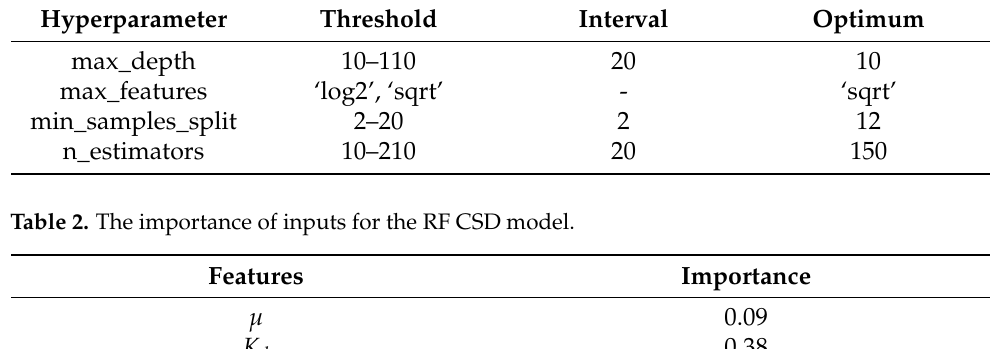
Table 1. Parameters setting to determine the optimal hyperparameters for the RF model.